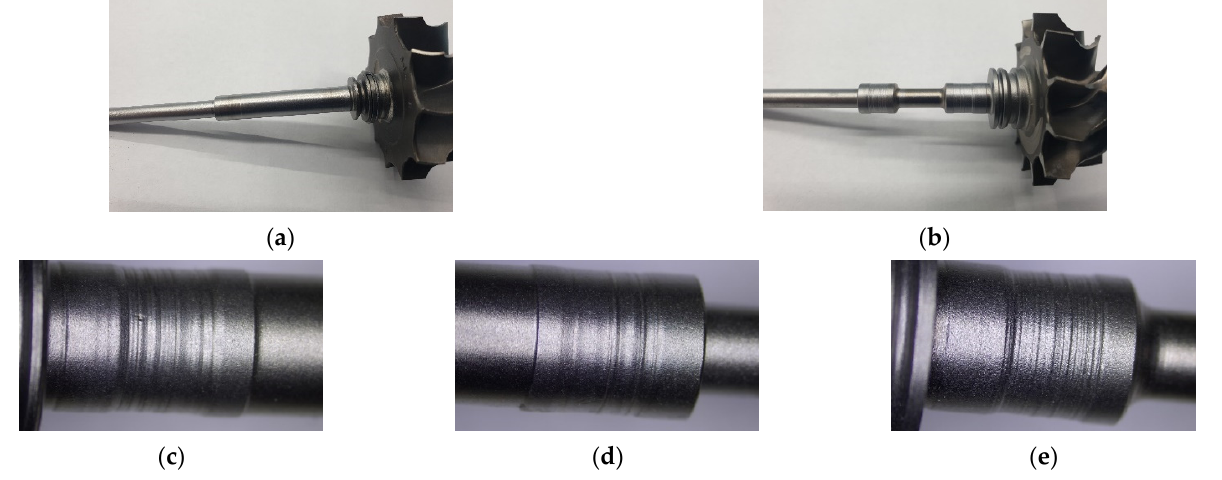
Figure 2. Views of the shafts with turbocharger turbine rotors. Renault Laguna 1.9 DCI, Garret 708,639 model ( a ); Peugeot 3071.6HDI, Garret 7534200375J6 model ( b ). Worn shaft journal surfaces (examples) ( c – e ).